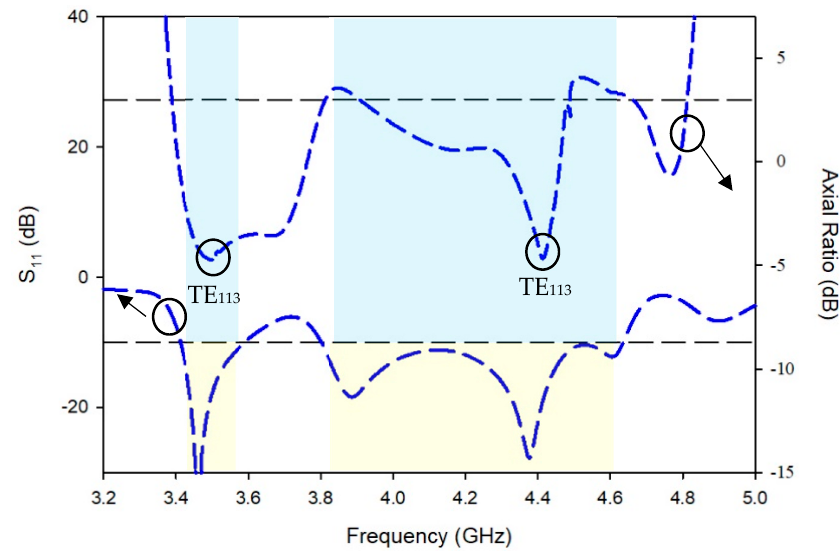
Figure 7. Simulated S-parameter and Axial ratio of the proposed RDRA.